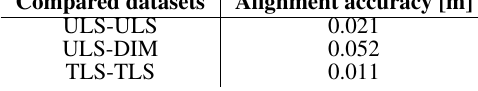
Table 1. Alignment accuracies between compared point clouds from UAV-borne laser scanning (ULS), UAV-borne photogrammetry using dense image matching (DIM), and terrestrial laser scanning (TLS). Alignment accuracies were derived as standard deviation of M3C2 distances in stable areas between point clouds of two